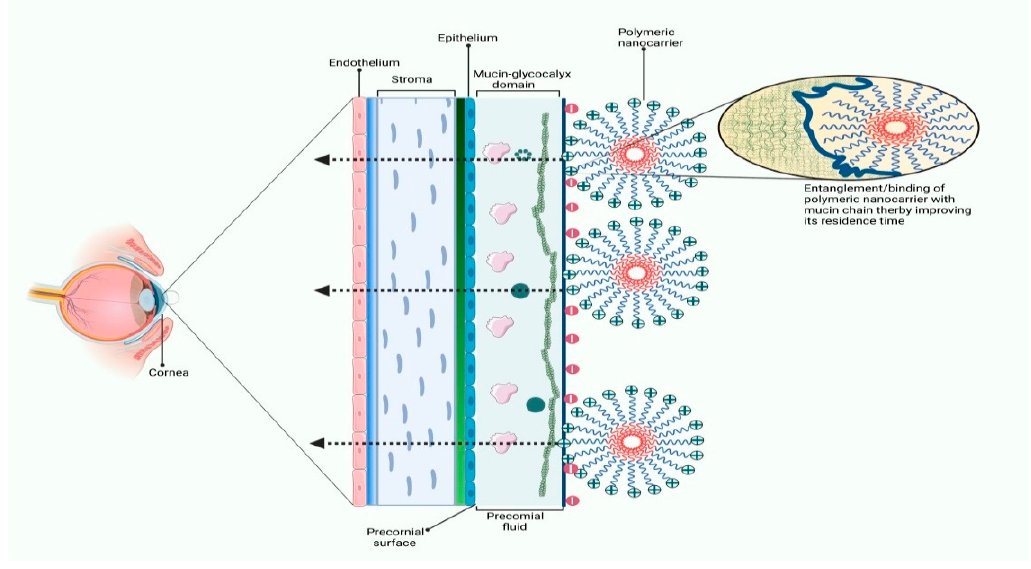
Figure 5. Illustration of ionic interaction of polymeric nanocarriers with corneal glycocalyx domain resulting in increased ocular surface contact and improved drug penetration.